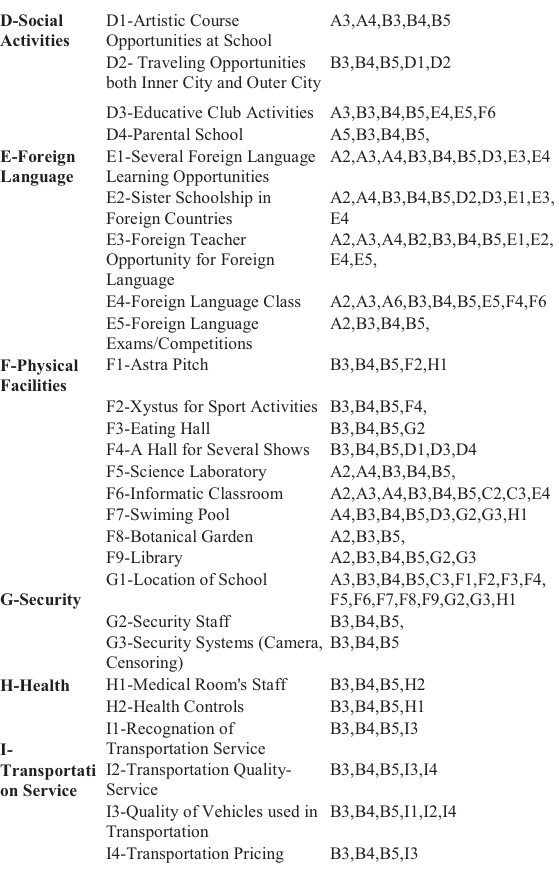
Table 2. The influence dimensions and sub criteria for private primary school